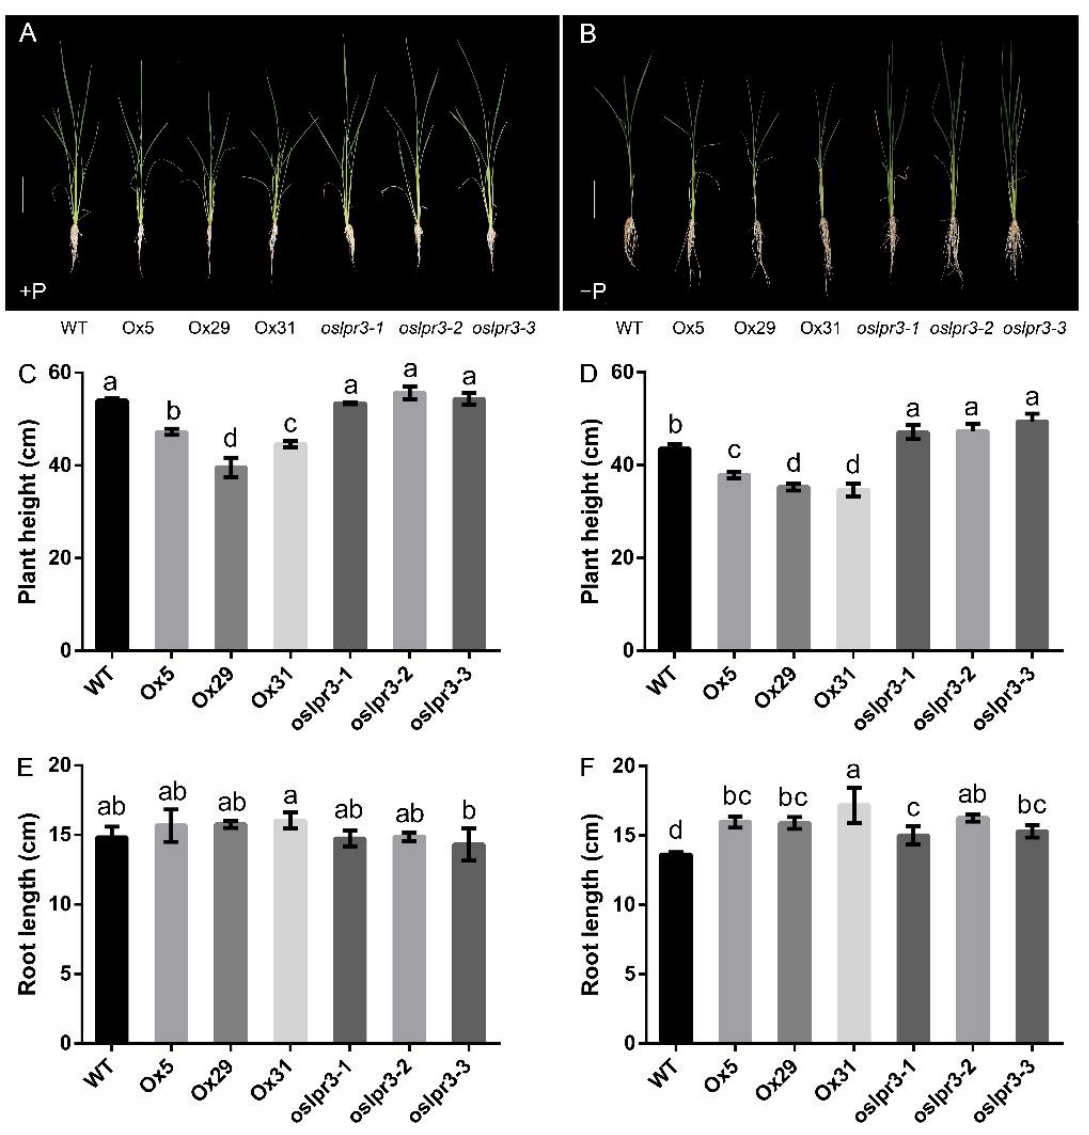
Figure 3. Growth of OsLPR3 -Ox and oslpr3 lines in response to Pi supply. Seedlings (10-d-old) of WT, OsLPR3 -Ox, and oslpr3 lines were grown hydroponically under +P and − P conditions for 21 d. ( A , B ) Photographs of the relative growth performances of WT, OsLPR3 -Ox, and oslpr3 lines under different Pi regimes. Scale bar = 10 cm. ( C , E ) Plant height and root length under +P conditions and ( D , F ) under − P conditions. Values are means ± SE ( n = 6). Different letters above the bars indicate significant differences ( p < 0.05, one-way